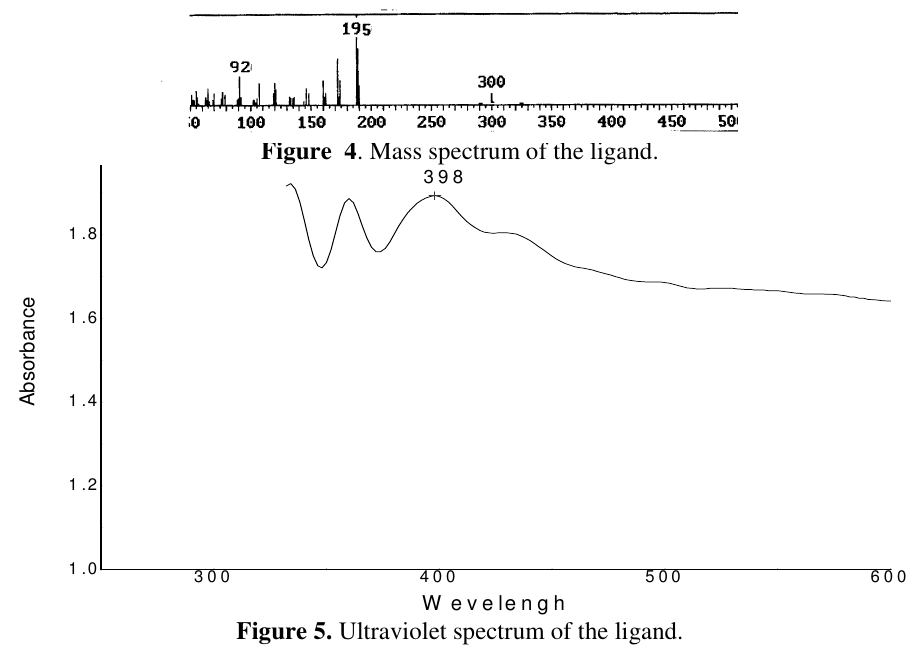
Figure 4 . Mass spectrum of the ligand.